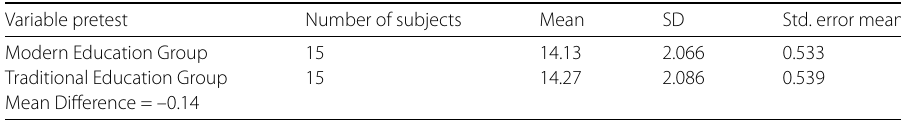
Table 1 Descriptive Statistics of Pre-test in Terms of Groups Variable pretest